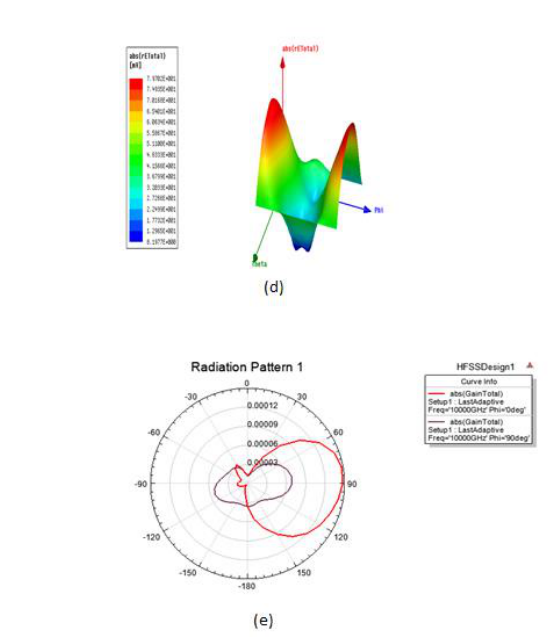
Figure 10: (d) Radiation pattern, (f) Gain total of a single bow tie graphene antenna over SiO2